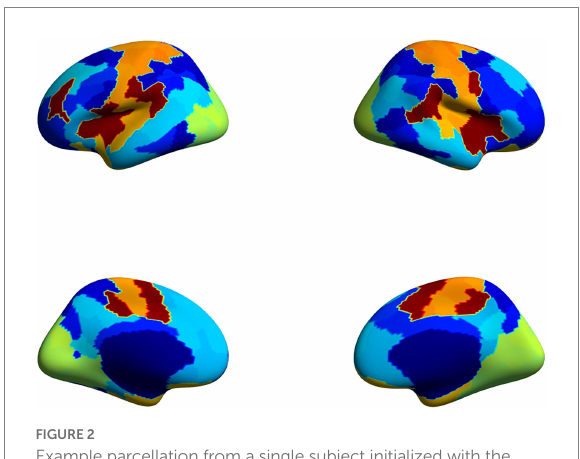
FIGURE 2 Example parcellation from a single subject initialized with the 200-parcel 7-network Schaefer atlas (Schaefer et al., 2018) with refined parcel borders that functionally correspond to the subject’s resting state data as a result of the GPIP